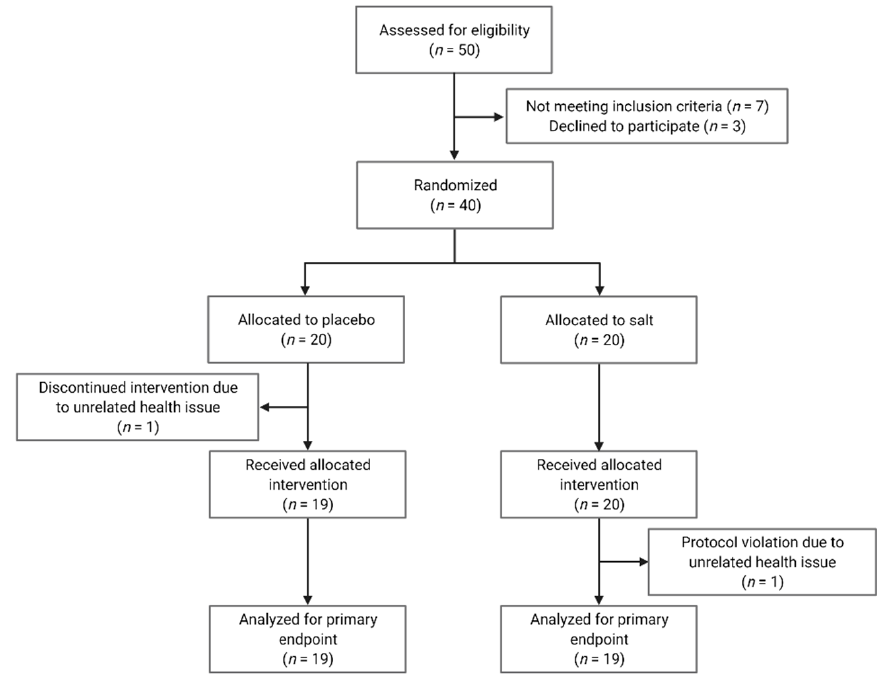
Figure 1. Consolidated Standards of Reporting Trials (CONSORT) flow diagram.